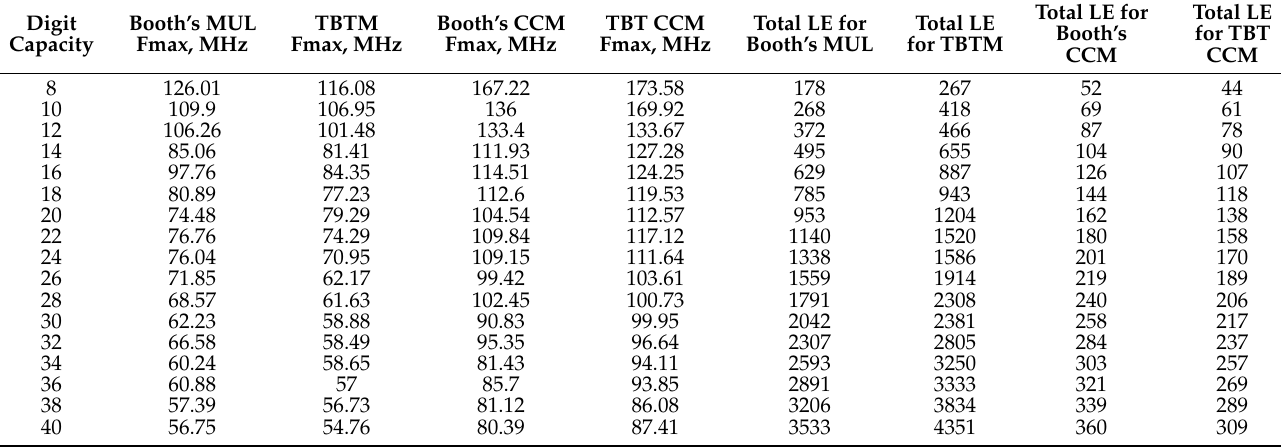
Table 9. Comparison characteristics of the